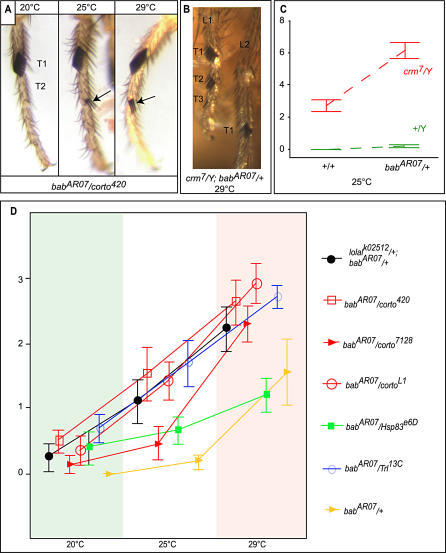
Chromatin Regulators, Temperature, and Sex Comb DevelopmentThe sex comb is a structure made of modified bristles located on the first tarsal segment of the first leg in males. (A) Sex comb phenotype of representative babAR07/corto420 males grown at 20 °C, 25 °C, and 29 °C. The normal sex comb is located on the first leg in the first tarsal segment (T1). Ectopic sex comb composed of two and three teeth, respectively, can be seen on the second tarsal segment (T2) in the flies grown at 25 and 29 °C (arrows).(B) Sex comb phenotype of crm7/Y; babAR07/+ of a fly grown at 29 °C. An ectopic sex comb caused by crm7 alone is visible on the first tarsal segment (T1) of the second leg (L2), a typical PcG phenotype as previously reported [35]. A strong synergistic interaction between bab and crm is revealed by ectopic sex comb teeth, not only on the second (T2) but also on the third (T3) tarsal segment of the first leg (L1). Note that the legs are shortened and that the second tarsal segment is inflated, affecting the ectopic sex comb shape.(C) Mean and standard errors of sex comb teeth on the second tarsal segment of the first leg in wild-type (green), babAR07/+, crm7/Y and crm7/Y; babAR07/+ (red) males grown at 25 °C.(D) Mean and standard errors of sex comb teeth on the second tarsal segment in babAR07/+ single heterozygotes and in combinations with the other mutations indicated on the right grown at 20 °C, 25 °C, and 29 °C.